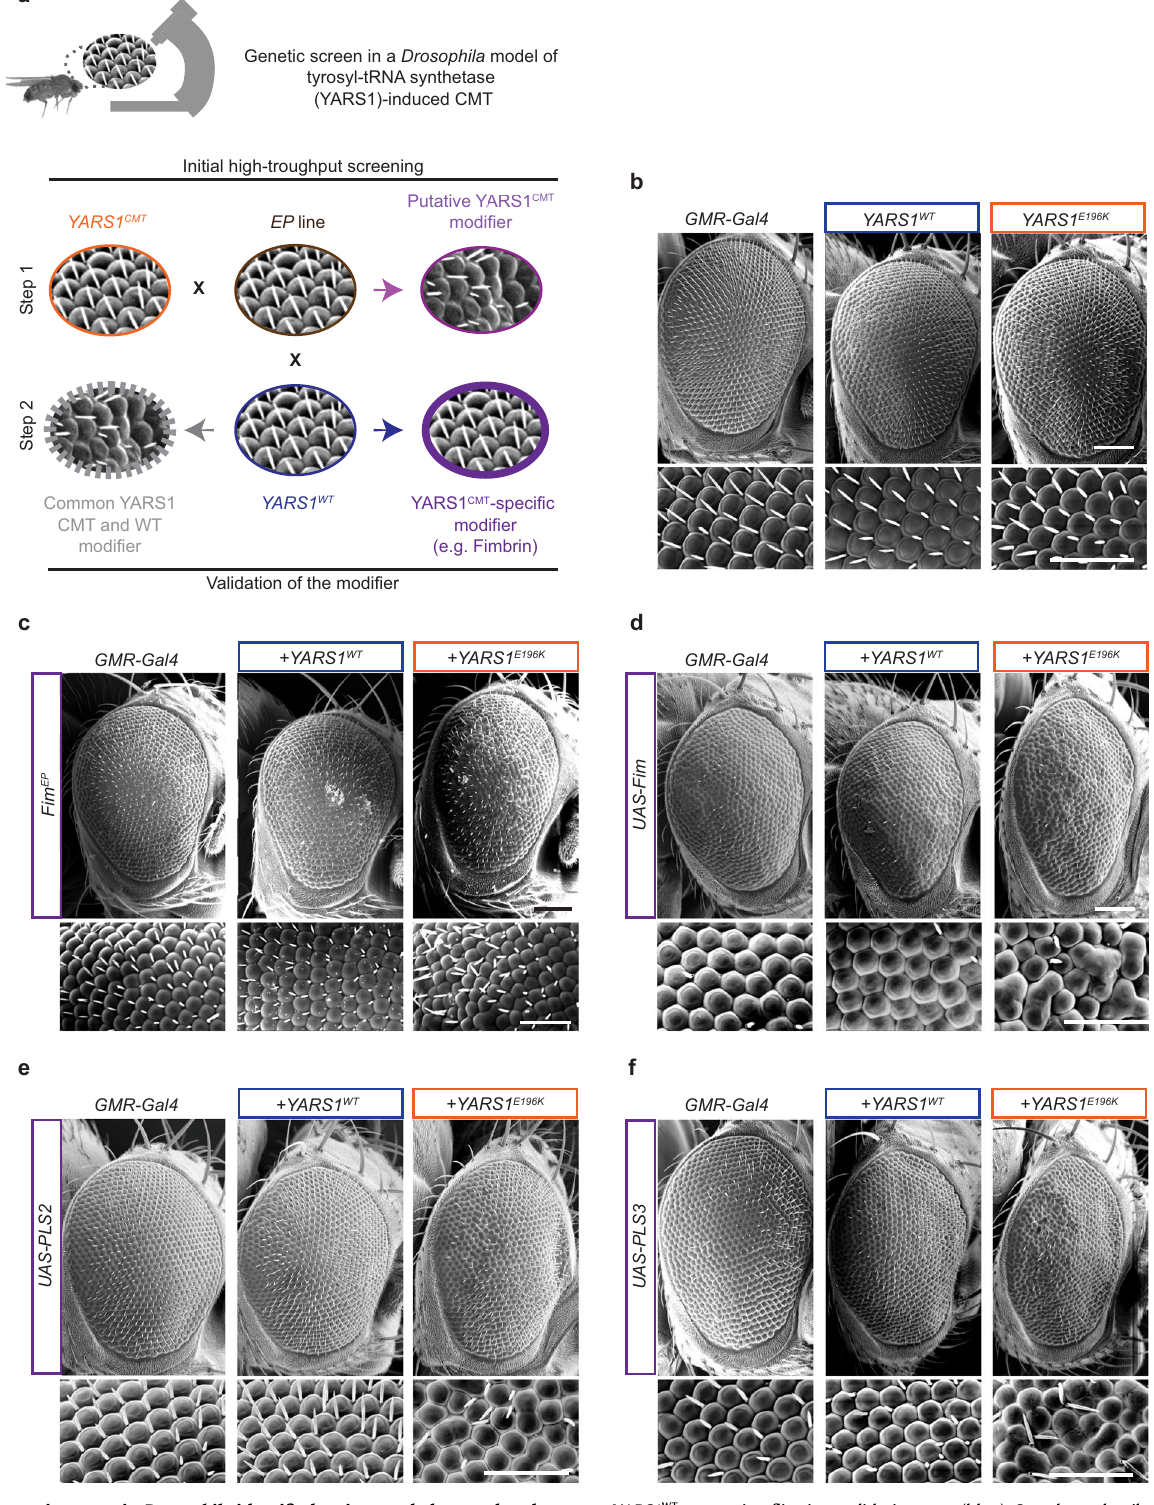
to YARS1 WT -expressing fl ies in a validation step (blue). See also a detailed descrip- tion in the Methods. Scanning electron micrographs of adult fl y eyes in b controls, and c upon co-expression of Fim EP . Assessment of interaction with transgenic UAS- Fim ( d ), and the human orthologs UAS-PLS2 ( e ) and UAS-PLS3 ( f ) with YARS1 WT or YARS1 E196K . The experiments were repeated at least three independent times with similar outcomes. Scale bars – 50 μ